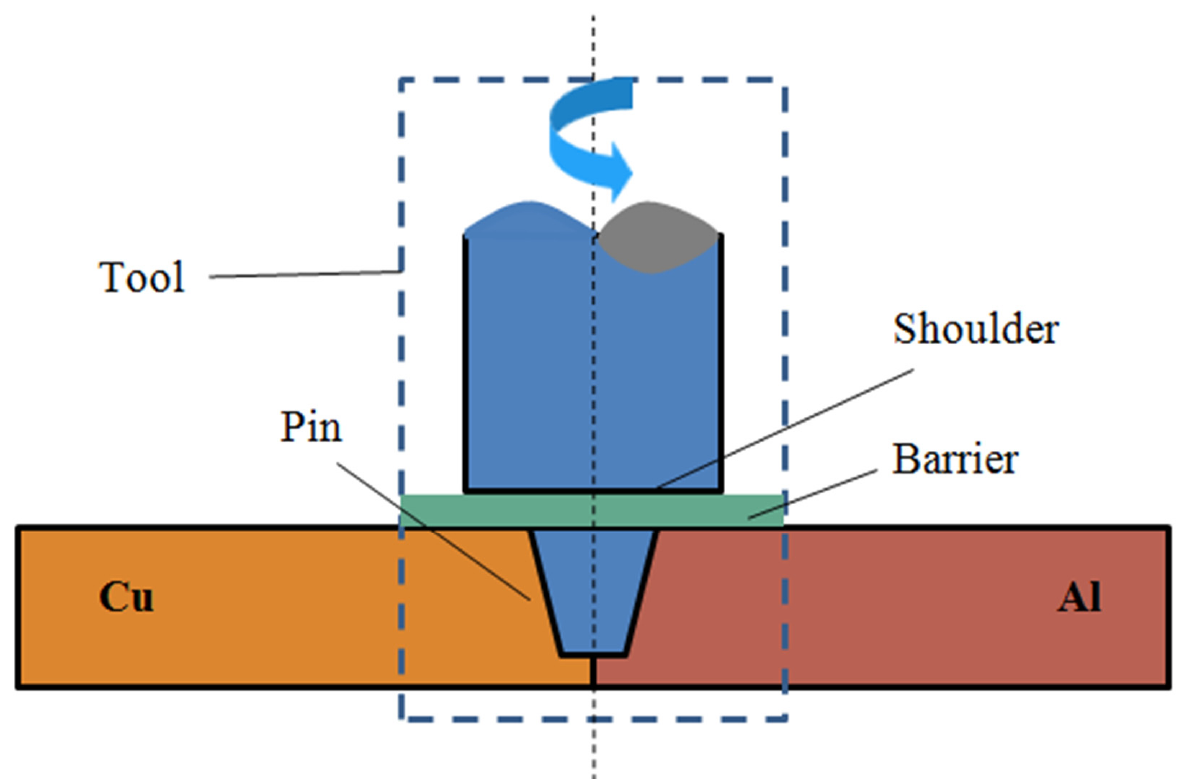
Figure 19. FSBBW schematic diagram.